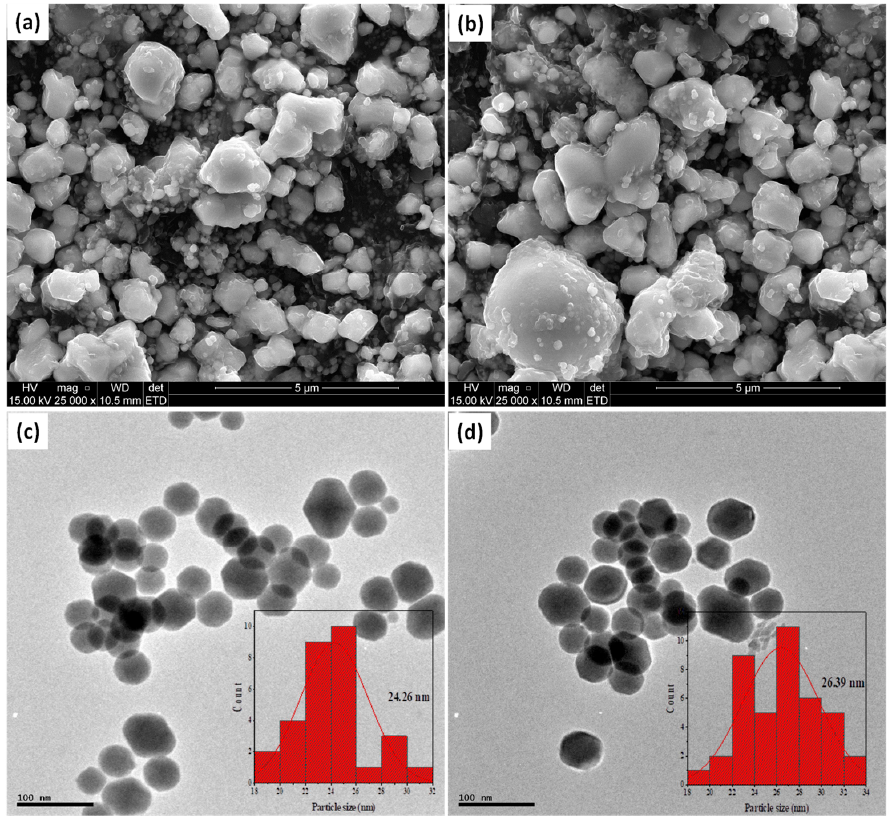
Figure 3. SEM images of ( a ) Cu 7 S 4 (220 °C) and ( b ) Cu 7 S 4 (250 °C); TEM images of ( c ) Cu 7 S 4 (220 °C) and ( d ) Cu 7 S 4 (250 °C). Insets are the respective particle size distribution histogram.